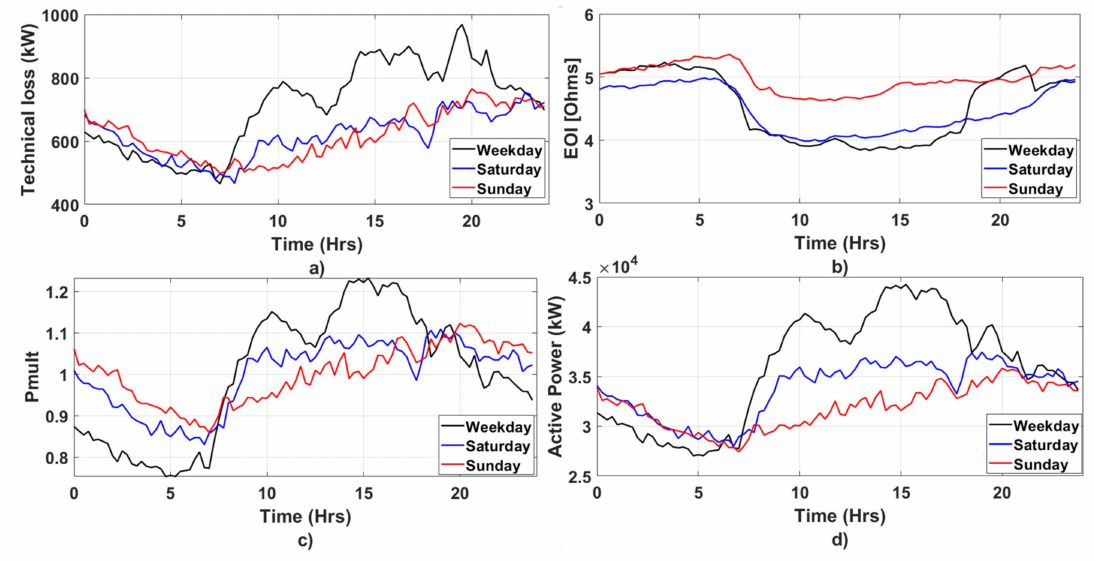
Figure 15. ( a ) Technical loss curve due to the regular loads supply; ( b ) Resistive part of EOI; ( c ) Distribution feeder’s loading curve due to billed power only; ( d ) Total feeder’s injected power curve due to billed and non-billed